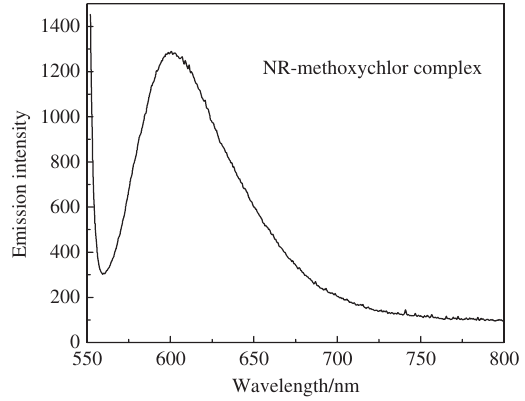
Figure 9 Emission spectrum of the NR-methoxychlor solid com- plex ( Hassoon and Schechter 2000 ).